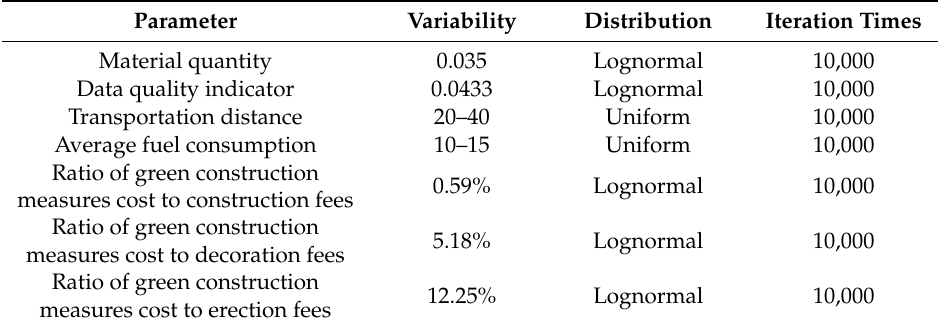
Table 10. Data uncertainty of each parameter in the